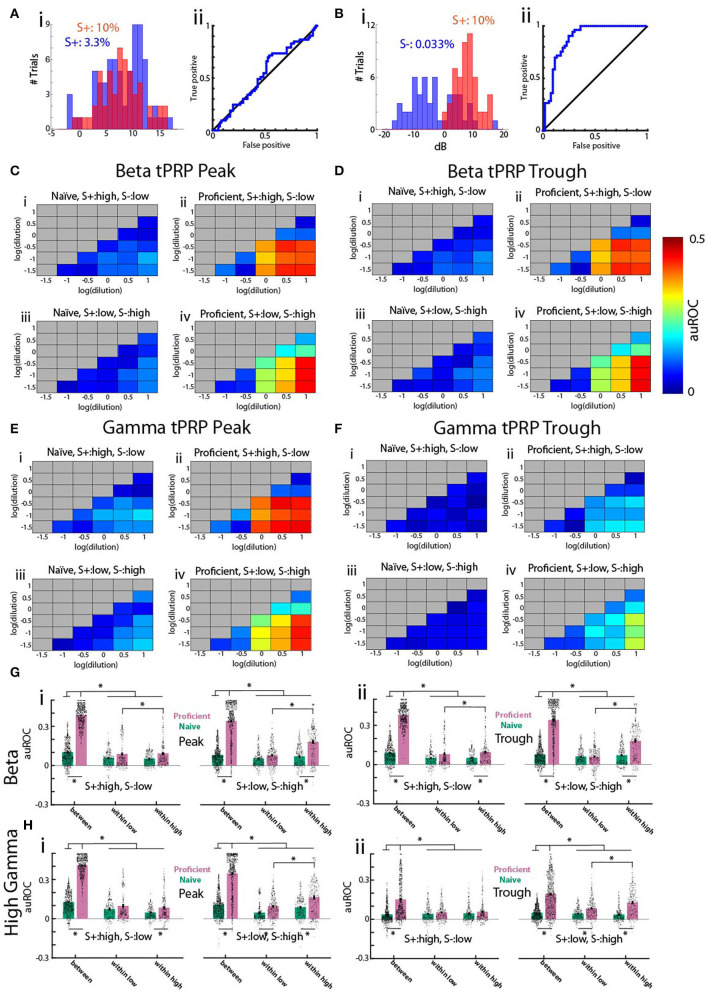
Receiver operating characteristic (ROC) analysis of the theta phase-referenced power for the go-no go task for odorant concentration. (A,B) Examples of histograms of gamma tPRP (i) and ROC curve (ii) for all proficient trials for acetophenone for one mouse. The rewarded stimuli (S+) were cliq ≥ 1%. (A) Histogram and ROC for 53 trials with 10% cliq and 72 trials with 3.3% cliq. (B) Histogram and ROC for 53 trials with 0.033% cliq and 53 trials with 10% cliq. (C–F) Pseudocolor diagrams showing the average area under the ROC curve (auROC) for each pairwise comparison for all odorant concentrations for gamma tPRP power. An auROC of 0.5 indicates non-overlapping distributions, and an auROC of 0 indicates completely overlapping distributions. (C,D) are for beta tPRP and (E,F) are for gamma. (C,E) are peak-referenced tPRP and (D,F) are trough-referenced tPRP. (i,ii) are naïve (i) and proficient (ii) trials for experiments where the three highest concentrations (cliq of 10, 3.3, and 1%) were the rewarded odorant (S+) and iii and iv were experiments where the three lowest concentrations (cliq of 0.33, 0.1, and 0.033%) were the rewarded odorant. The average was calculated for each of the 16 electrodes for nine mice. (G,H) Bar graphs showing the average auROC for pairwise comparisons for all odorant concentrations for beta (E) or gamma (F) tPRP power for nine mice and 16 electrodes per mouse. Points in the violin plot shows the average auROC per electrode per mouse. (i) is peak-referenced tPRP and (ii) is trough-referenced tPRP. Each panel shows on the left the results per electrode for experiments where the three highest concentrations (cliq of 10, 3.3, and 1%) were the rewarded odorant (S+, left) and on the right the results for experiments where the three lowest concentrations (cliq of 0.33, 0.1, and 0.033%) were the rewarded odorant. The pairwise comparisons were grouped as comparisons between the low and high concentration ranges (between), between all concentrations within the low concentration range (within low) and between all concentrations within the high concentration range (within high). A GLM for the beta tPRP auROC yielded significant differences for proficient vs. naïve and high S+ vs. low S+ (p < 0.001, 17,888 observations, 17,964 d.f., F-statistic = 1,180, p-value for F-statistic < 0.001), but did not yield a statistical significance between peak and trough (p > 0.05). A GLM for the gamma tPRP auROC yielded significant differences for proficient vs. naïve, peak vs. trough and high S+ vs. low S+ (p < 0.001, 17,888 observations, 17,964 d.f., F-statistic = 880, p-value for F-statistic < 0.001). Asterisks denote significant post-hoc statistical difference assessed with either t-test or ranksum tests corrected for multiple comparisons, pFDR = 0.039 (Ei), 0.04 (Eii), 0.036 (Fi), and 0.045 (Fii).